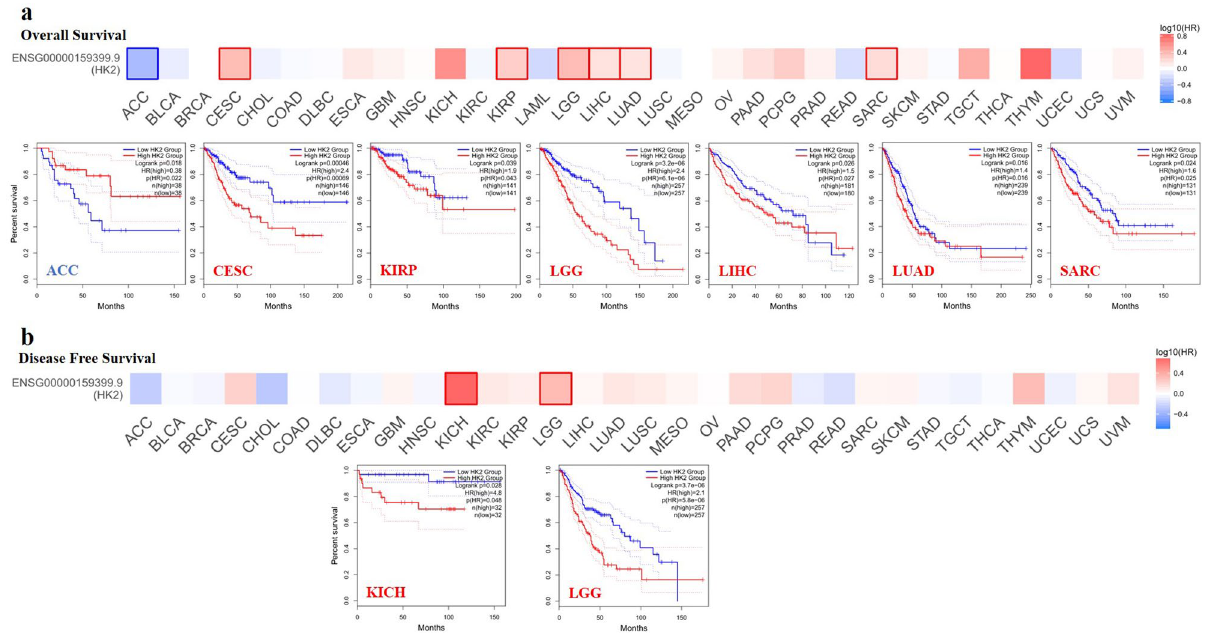
Figure 2. Correlation between HK2 gene expression and survival prognosis of cancers in TCGA. The GEPIA2 was used to perform overall survival ( a ) and disease-free survival ( b ) analyses of different tumors in TCGA by HK2 gene expression. The survival map and Kaplan–Meier curves with positive results are